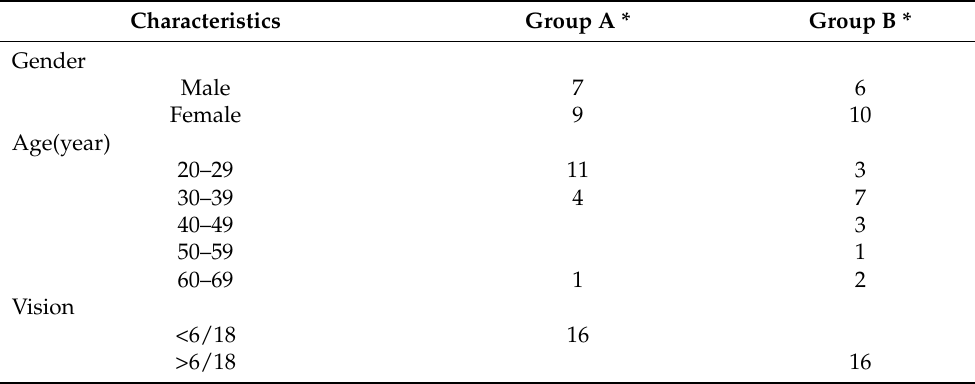
Table 4. Characteristics of the participants in each